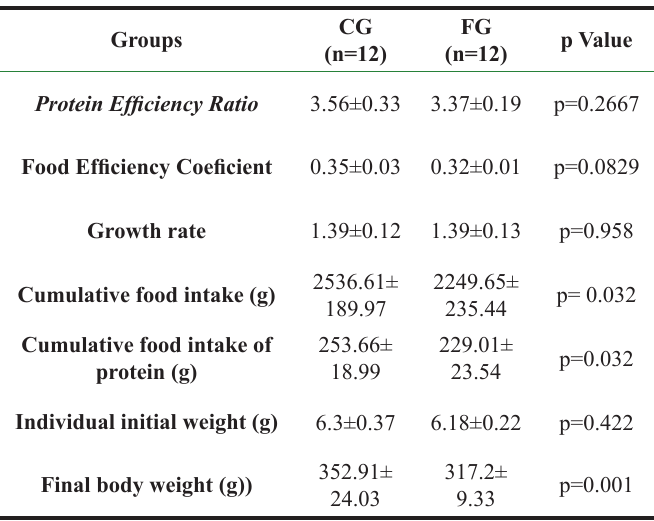
TABLE 2 - Data from biological analysis of offspring and of the experimental